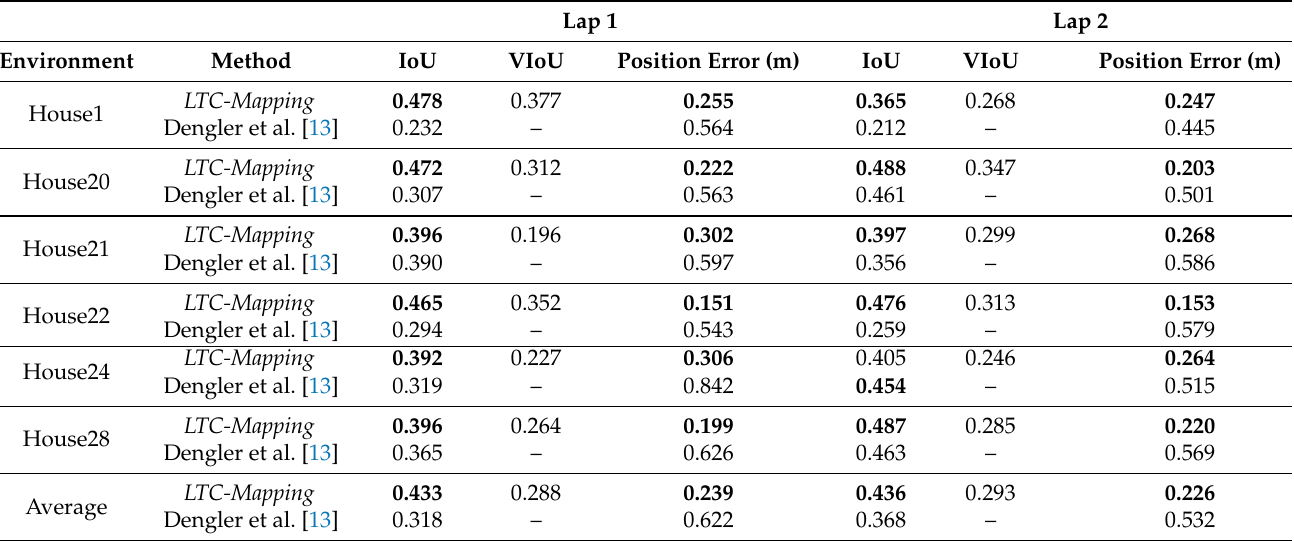
Table 1. Geometric evaluation for each environment of the evaluated methods through the Intersec- tion over Union (IoU) function and its Volumetric form (VIoU), and the error between the centers of masses of the ground-truth and the object representation in the map. Best results are marked in bold. Lap 1 Lap 2